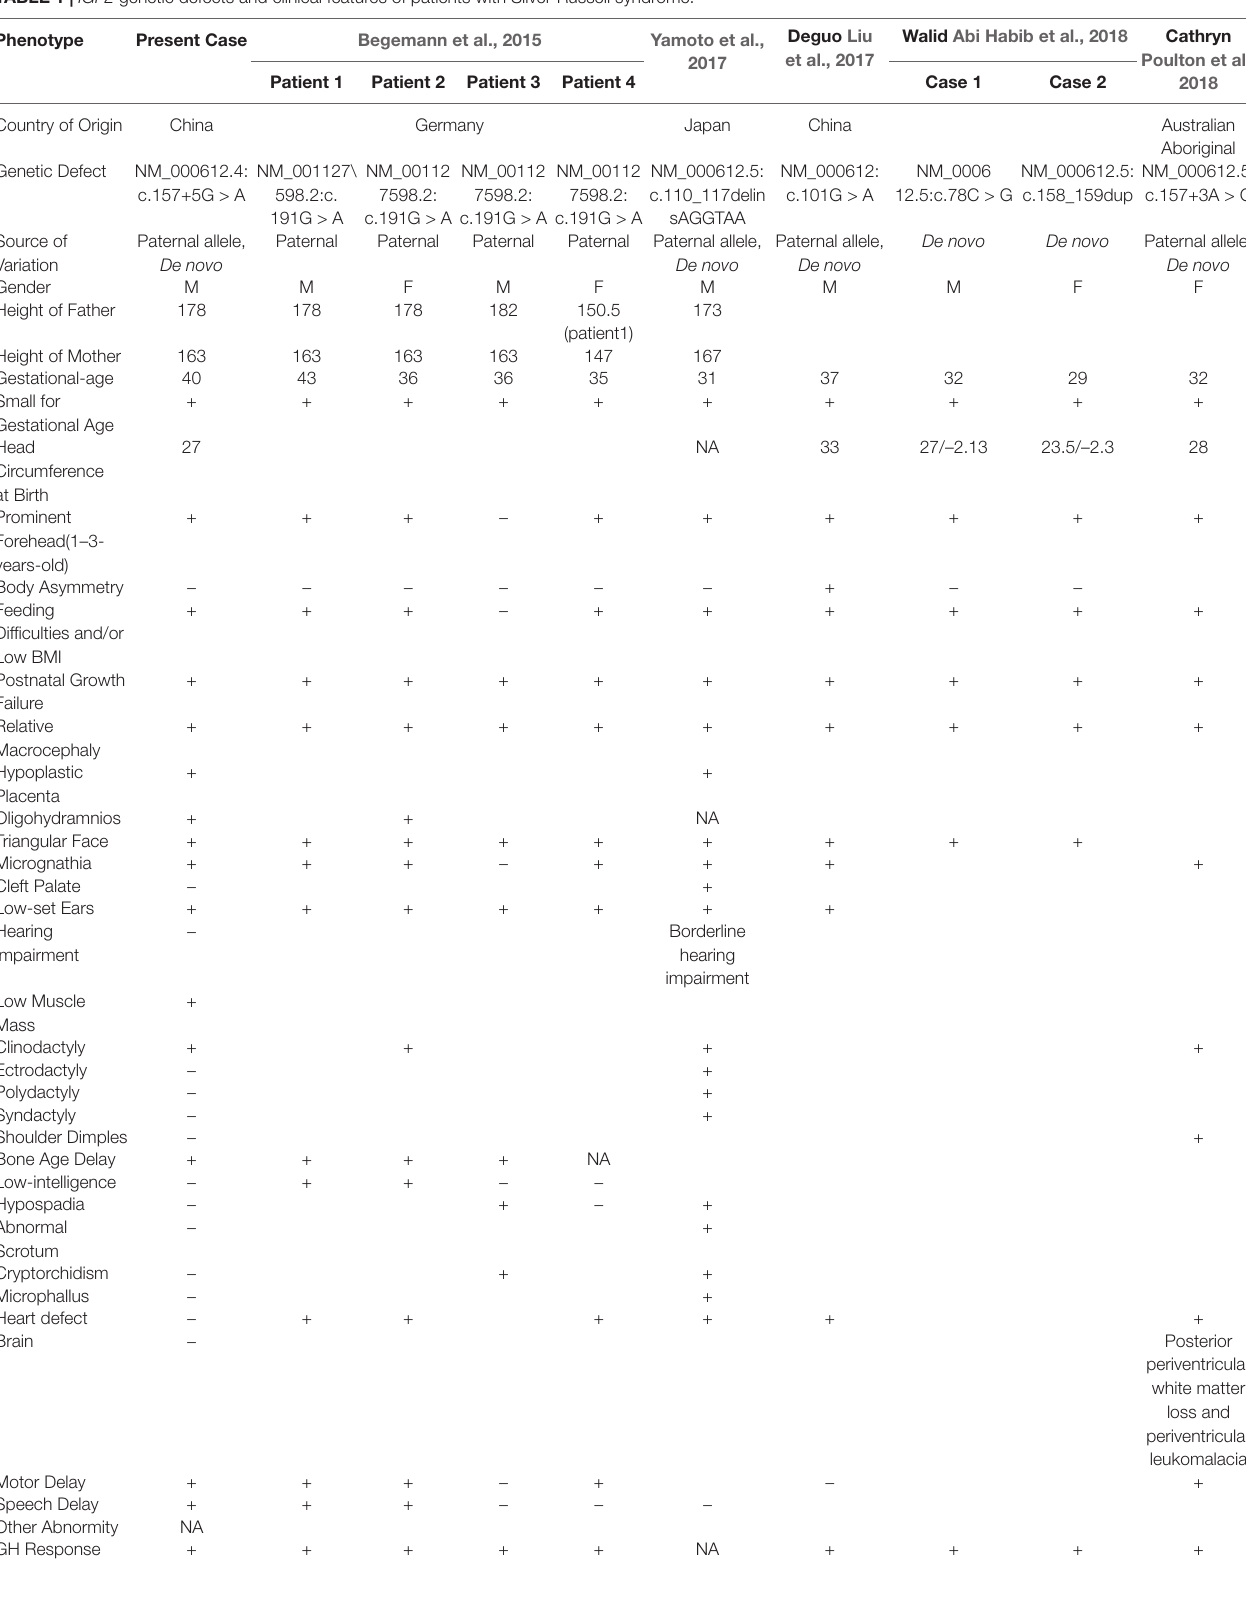
TABLE 1 | IGF2 genetic defects and clinical features of patients with Silver-Russell